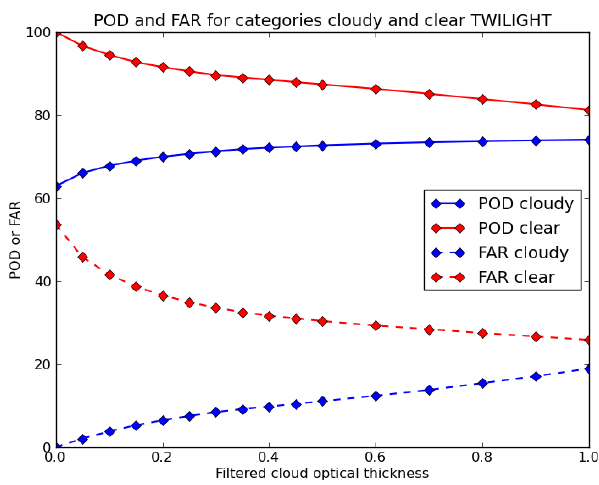
Fig. 13. Same visualisation as in Fig. 11 but for category twilight.